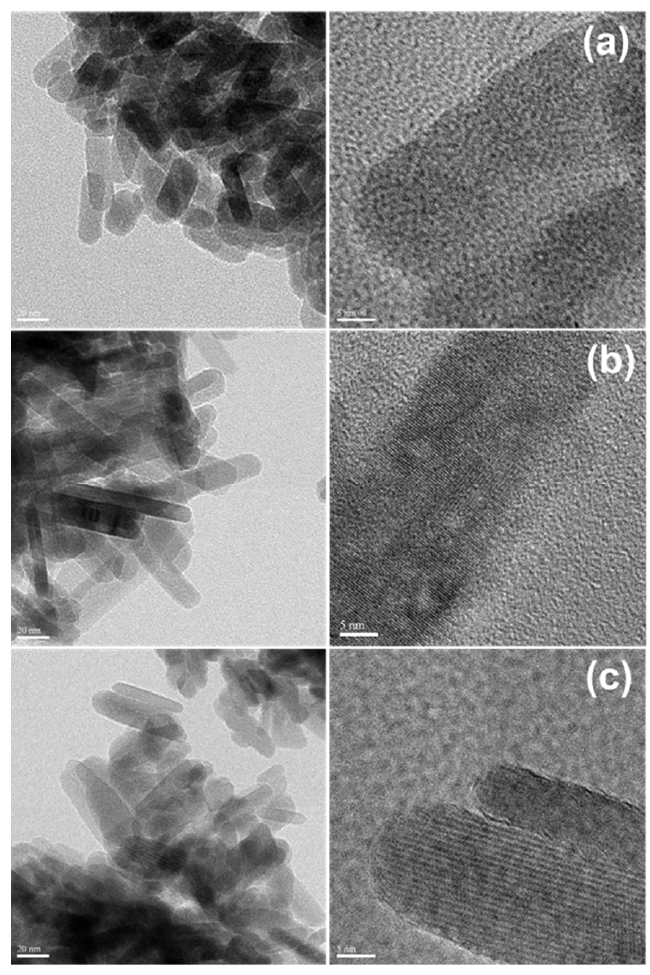
Figure 2. HRTEM images of F-HAp: ( a ) F-HAp synthesized in SBF at 0.01 M of NaF, ( b ) F-HAp synthesized in SBF at 0.005 M of NaF, and ( c ) F-HAp synthesized in SBF at 0.0025 M of NaF.